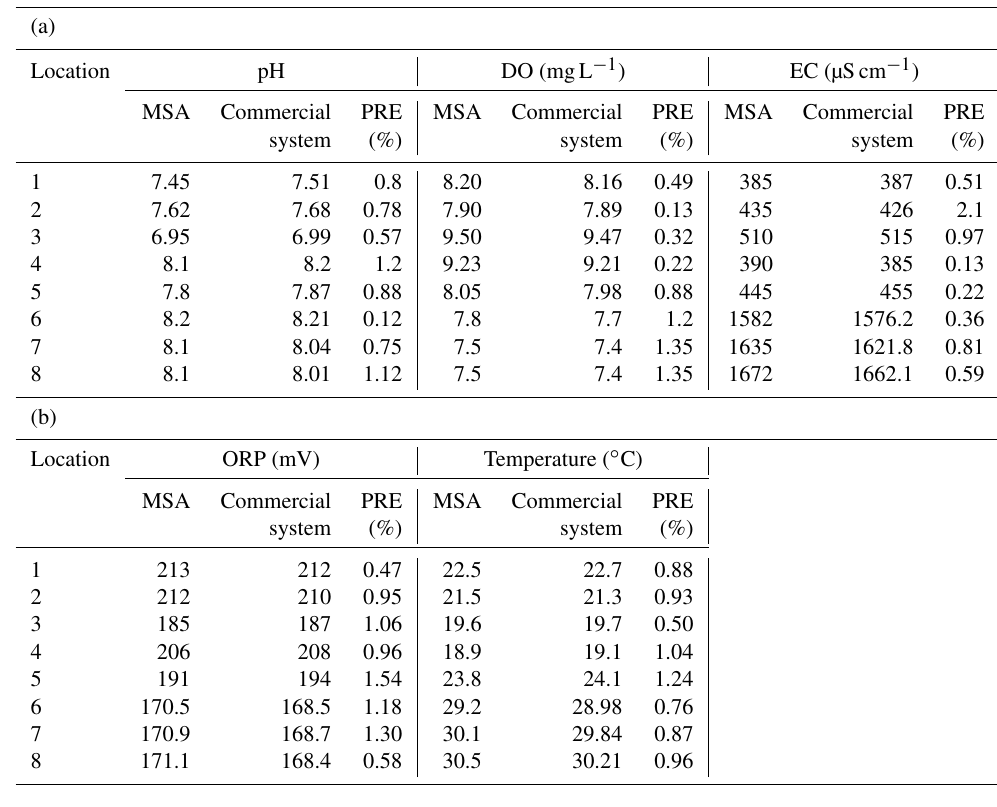
Table 2. (a) Average values of samples for pH, DO, and EC and their calculated PRE. (b) Average values of samples for ORP and temperature and their calculated PRE.